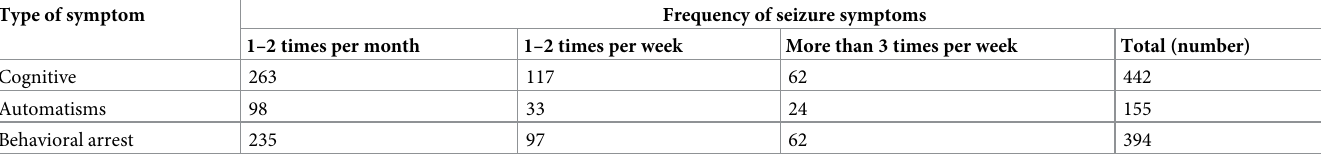
Table 5. The frequency of focal impaired-awareness seizure symptoms as outcome of questionnaires.